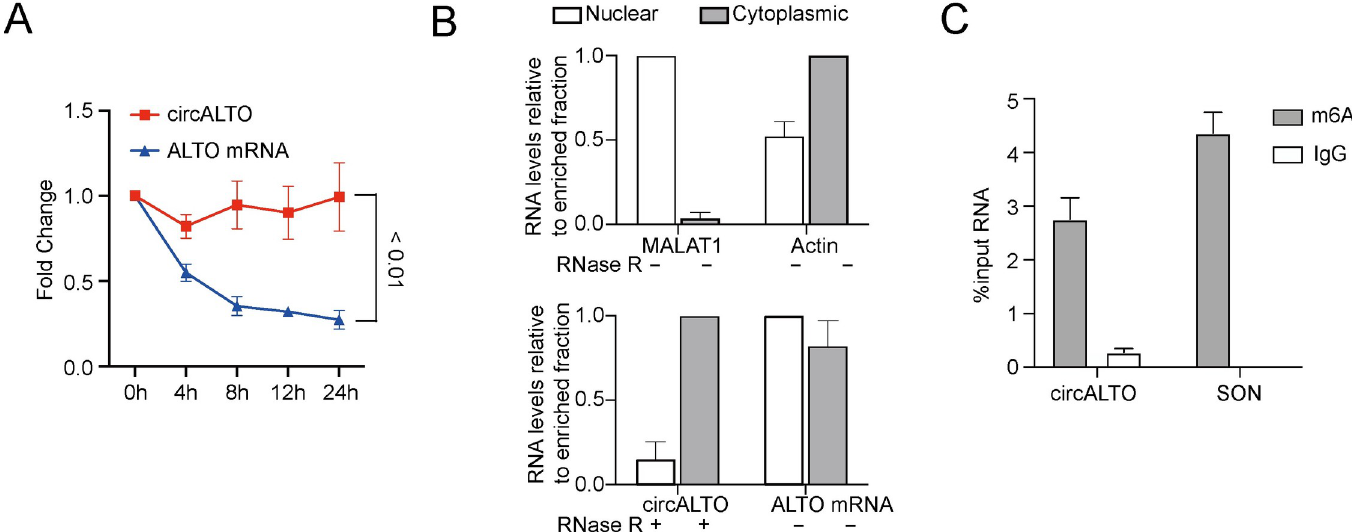
Fig 2. Characterization of circALTO. (A) The expression of circALTOs and its linear mRNA counterparts after treatment with Actinomycin D at the indicated time points in WaGa cells by qRT–PCR analysis. Both circALTO and linear ALTO were normalized to 18S and then compared to levels at the pre-treatment (0 h) time point. Error bars calculated the SD from 3 biological replicates. The P value was determined using two-tailed t-test. (B) WaGa were fractionated and analyzed by qRT-PCR. MALAT1 and ACTB served as nuclear and cytoplasmic fractionation controls respectively. Values are normalized to the enriched fraction. Error bars were calculated from 3 biological replicates. (C) qRT-PCR of m 6 A or IgG control RNA immunoprecipitation (RIP) of VP-MCC cell lines WaGa. SON, m 6 A RNA IP control. Error bars represent SD (n = 3 biological